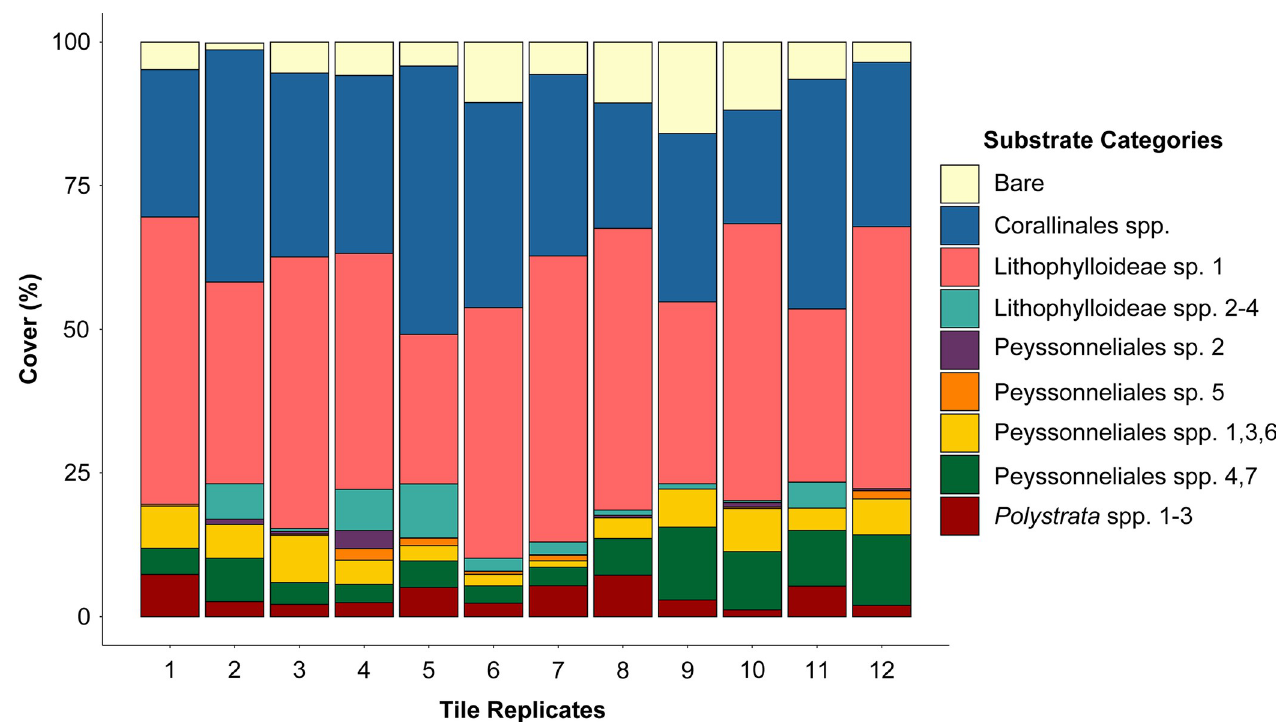
Fig 5. Substrate community composition of the 12 coral recruitment tiles. The abscissa lists the 12 recruitment tiles, the ordinate shows percent cover. Colors match substrate category colors in Figs 1 and 4.